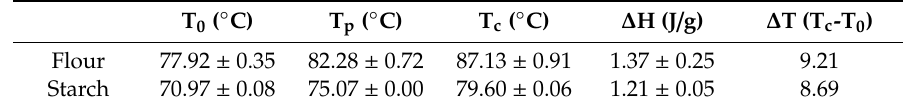
Table 7. Thermal transitions (di ff erential scanning calorimetry—DSC) and enthalpy of teosinte flour and starch.